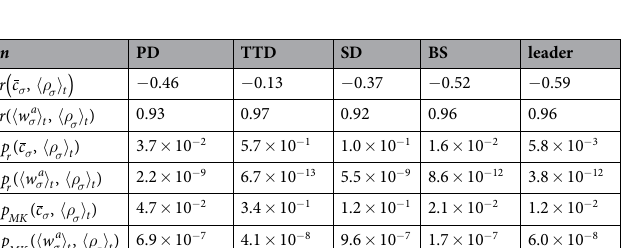
Figure 2. Costly signaling. ( a ) to ( e ) Time average density of signals produced in the population 〈 ρ σ 〉 t , as a function of their payoff 〈 〉 σ w a averaged over the same time period for five different game structures. Insets show t 〈 ρ σ 〉 t , as a function of normalized cost c (cost divided by mean payoff). When signal densities are plotted against apparent cost, a puzzling picture emerges: not only costly signals are produced, but also signals show little or no dependence on their cost. However, by plotting the signal density against their payoff, a strong pattern emerges: signal densities are distributed as an increasing function of their payoff.